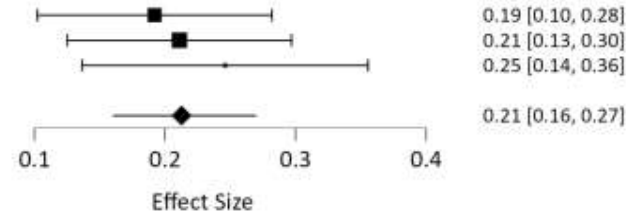
Figure 7. Forest plot of meta-analysis of Identified regulation and Intellect